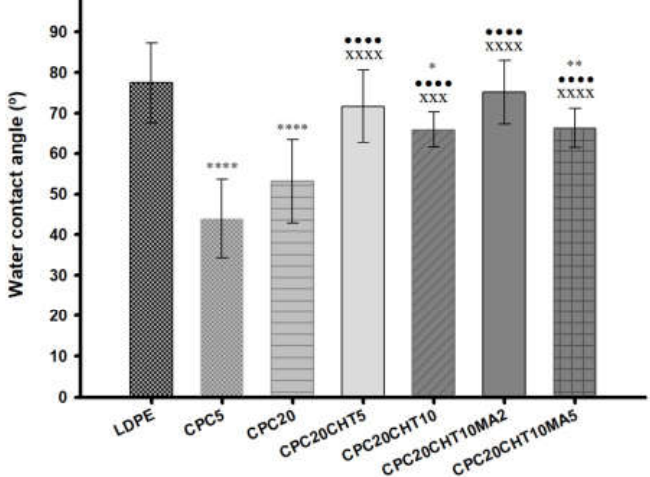
Figure 4. The water contact angles of the pristine LDPE and the CPC with and without chitosan and a coupling agent. The means ± standard deviation (SD) are illustrated. The significance levels between groups were 1 symbol— p < 0.05, 2 symbols— p < 0.01, 3 symbols— p < 0.001 and 4 symbols— p <